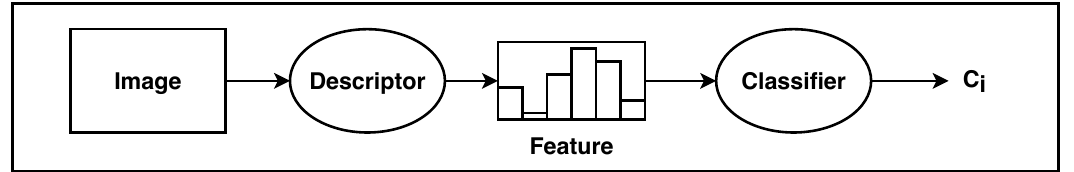
Figure 3. Classification of a new image given a descriptor and a